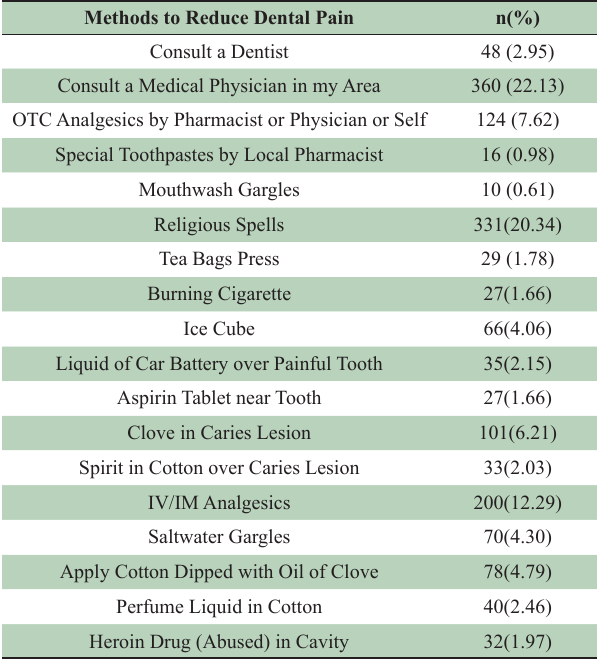
Table-V: Methods Employed to Deal with Toothache.